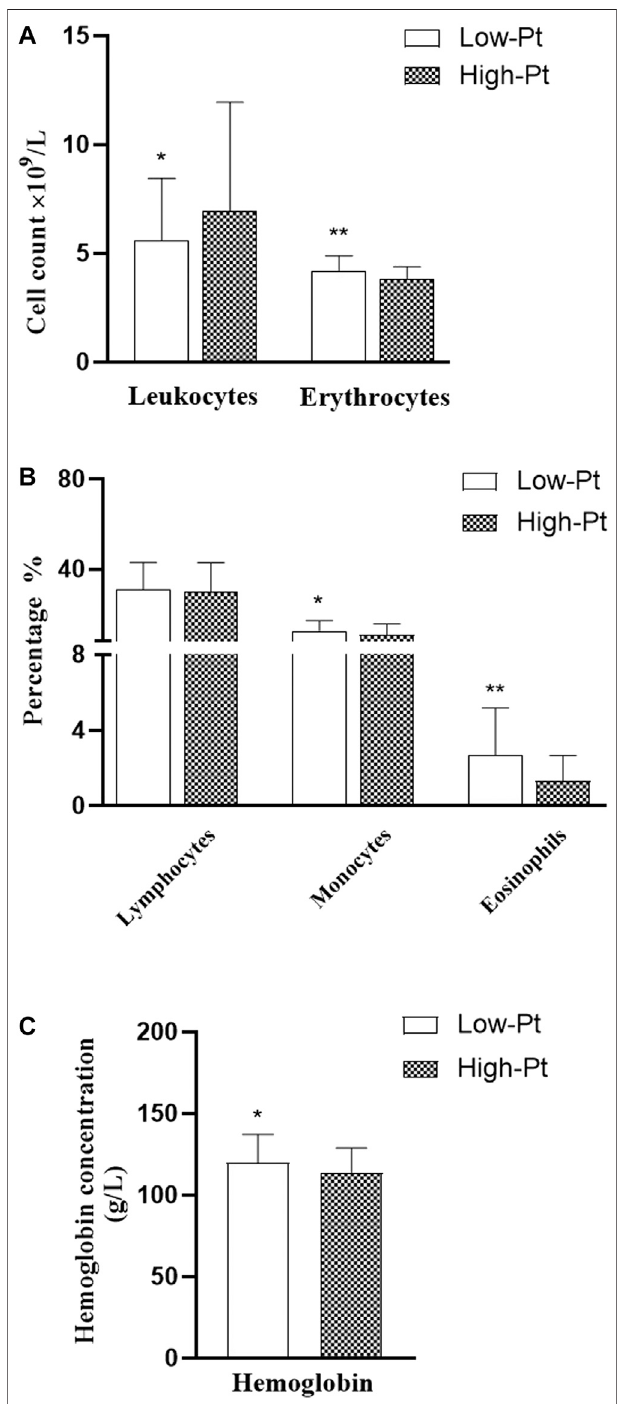
FIGURE 1 | Comparison of hemocytes in the low- and high-platinum groups. Low-Pt group, n (cid:1) 77, High-Pt group, n (cid:1) 58. a: leukocyte and erythrocytecountsb:percentageoflymphocytes,monocytesandeosinophils c: level of hemoglobin. **: p < 0.01; *: p < 0.05.